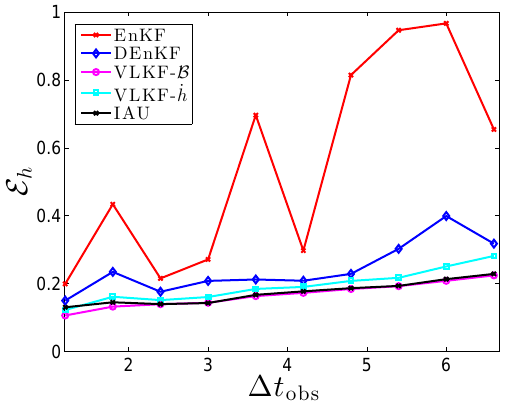
Fig. 5. Rms error of the analysis as a function of the observation interval ∆ t obs (in hours) for the slow variables { x j } .